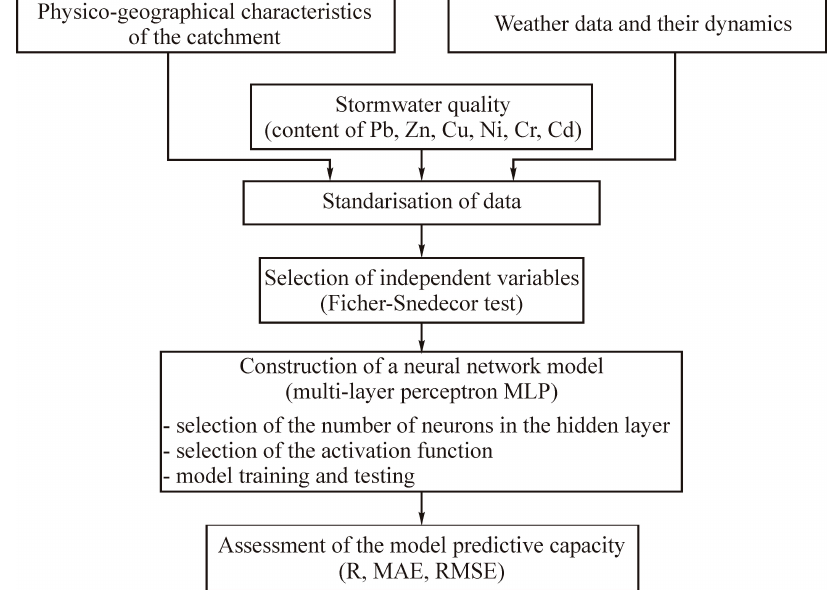
Figure 2. Methodology of the development of multi-layer perceptron (MLP) model for predicting the selected pollutant concentrations in stormwater.